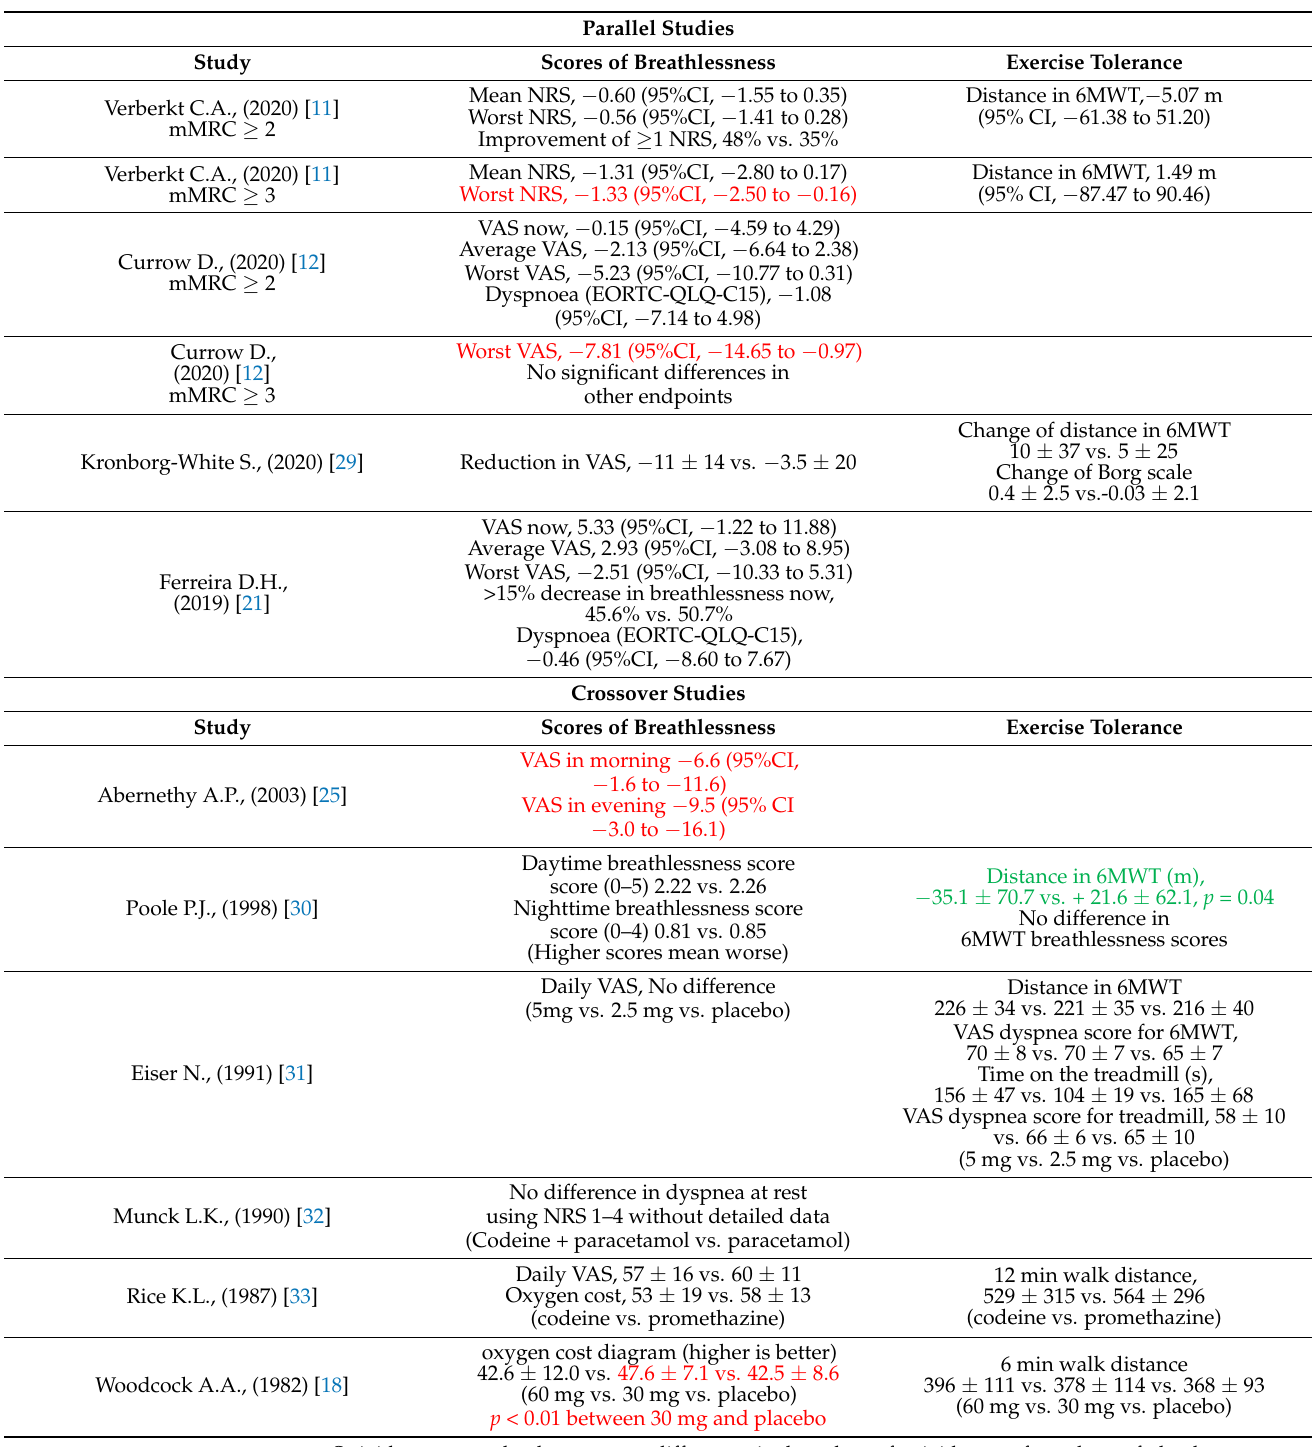
Table 2. Outcomes of randomized controlled studies regarding regularly used systemic opioids for non-cancer chronic respiratory